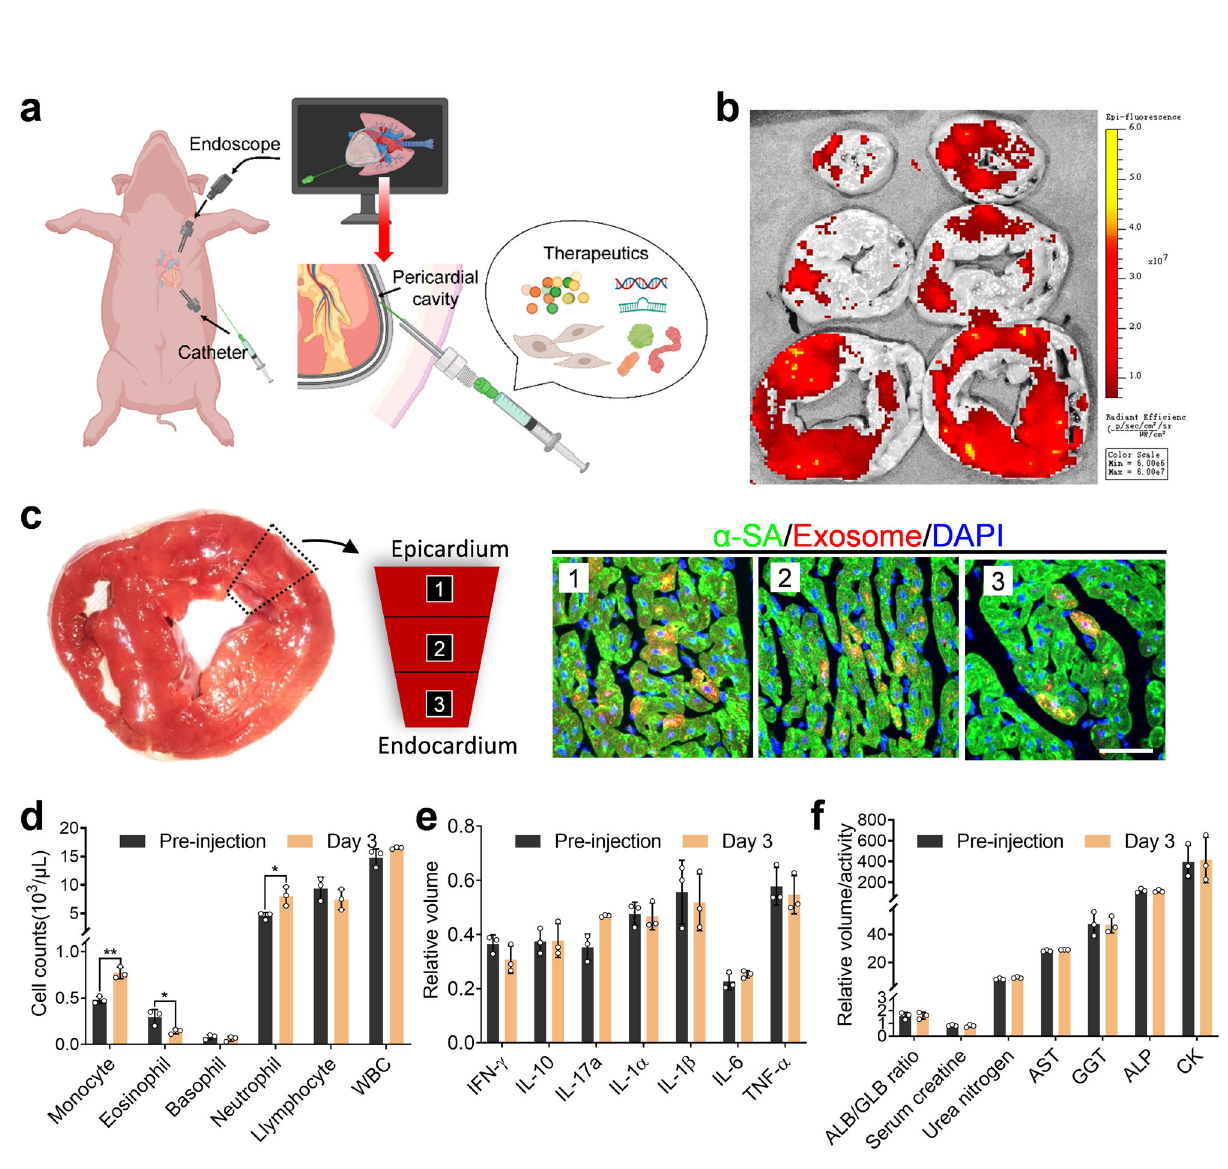
Fig. 5 Minimally invasive iPC injection of therapeutics in pigs. a Schematic illustration of minimally invasive delivery of therapeutics into pericardial cavity with the aid of endoscope in pigs. b Representative ex vivo imaging of pig hearts 3 days after intrapericardial injection of exosomes. c Confocal microscopy images showing uptake of exosomes by cardiomyocytes 3 days after iPC injection. Scale bar, 60 μ m. This study was repeated in three pigs and similar results were obtained. d Analysis of blood cells, e in fl ammatory cytokines in pericardial fl uid, and f serum chemistry on hepatic, renal, and cardiac functions. Data are expressed as mean ± SD, n = 3 animals. Comparison of two groups was performed with the unpaired, two-tailed Student ’ s t -test, * p < 0.05. Monocyte: p = 0.0022; eosinophil: p = 0.0362, neutrophil: p = 0.0268. Source data are provided as a Source Data fi le. WBC white blood cells, AST aspartate aminotransferase, GGT γ -glutamyl transferase, ALP alkaline phosphatase, CK creatine kinase, IL interleukin, TNF- α tumor necrosis factor- α .